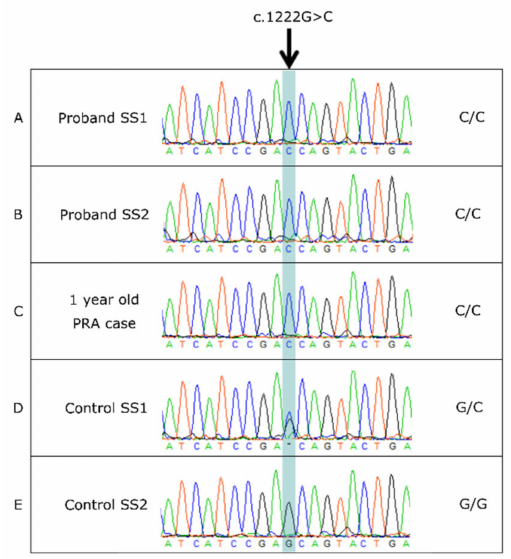
Figure 3. Sanger sequencing of the BBS2 c.1222G>C variant confirmed its presence in proband SS1 (track ( A )). Additional dogs were also homozygous for the c.1222G>C variant (tracks ( B , C )). SSs heterozygous for the variant and homozygous for the wild-type allele (G/G) are shown in tracks ( D ) and ( E ),